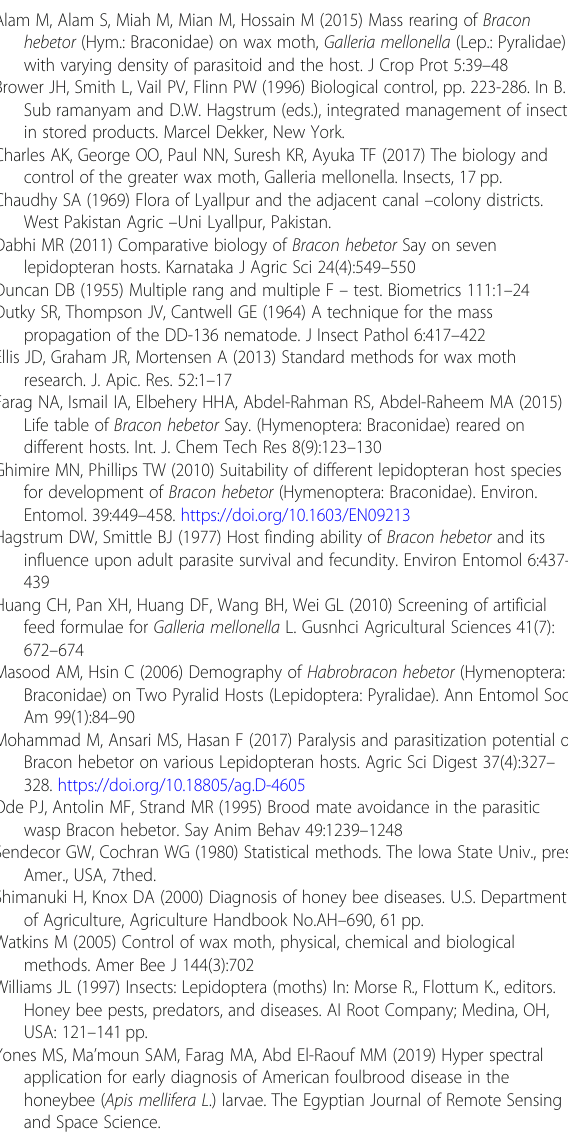
Life table of Bracon hebetor Say. (Hymenoptera: Braconidae) reared on different hosts. Int. J. Chem Tech Res 8(9):123 – 130 Ghimire MN, Phillips TW (2010) Suitability of different lepidopteran host species for development of Bracon hebetor (Hymenoptera: Braconidae).